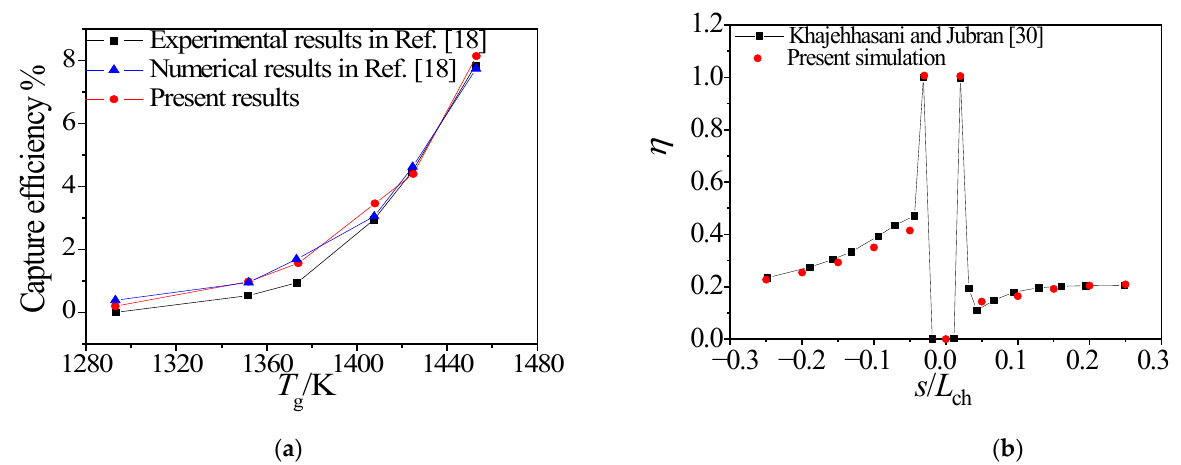
Figure 3. Validation of the numerical model. ( a ) Validation of the deposition model, ( b ) validation of the turbulence model.